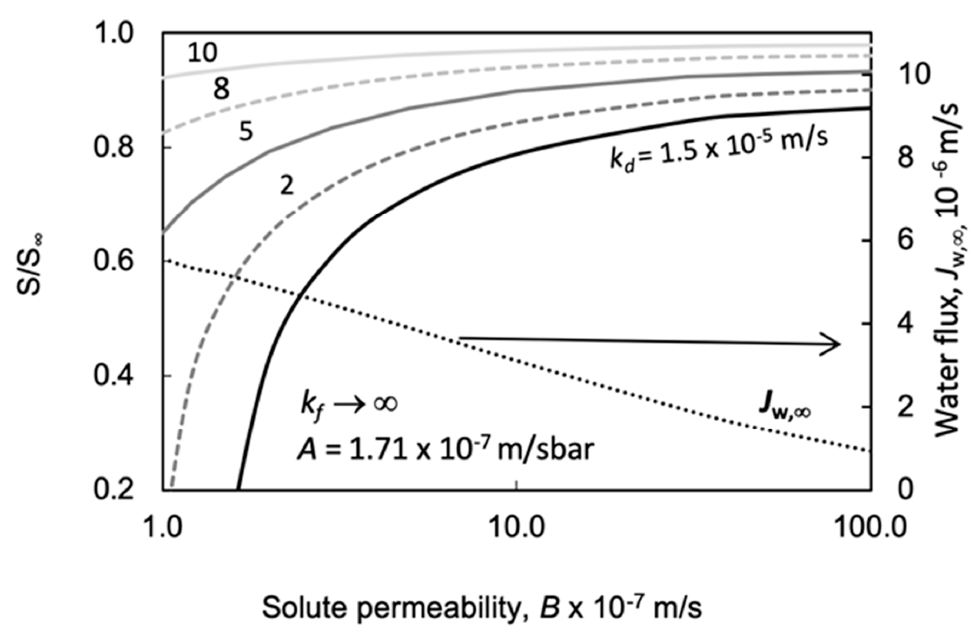
Figure 14. Effect of the solute permeability on the value of S/S ∞ and on the water flux, J w , ∞ , as a function of draw side mass transfer coefficient, in a PRO system; C d = 1.0 M; S ∞ = 803 μ m; k f → ∞ ; other parameters as in Table